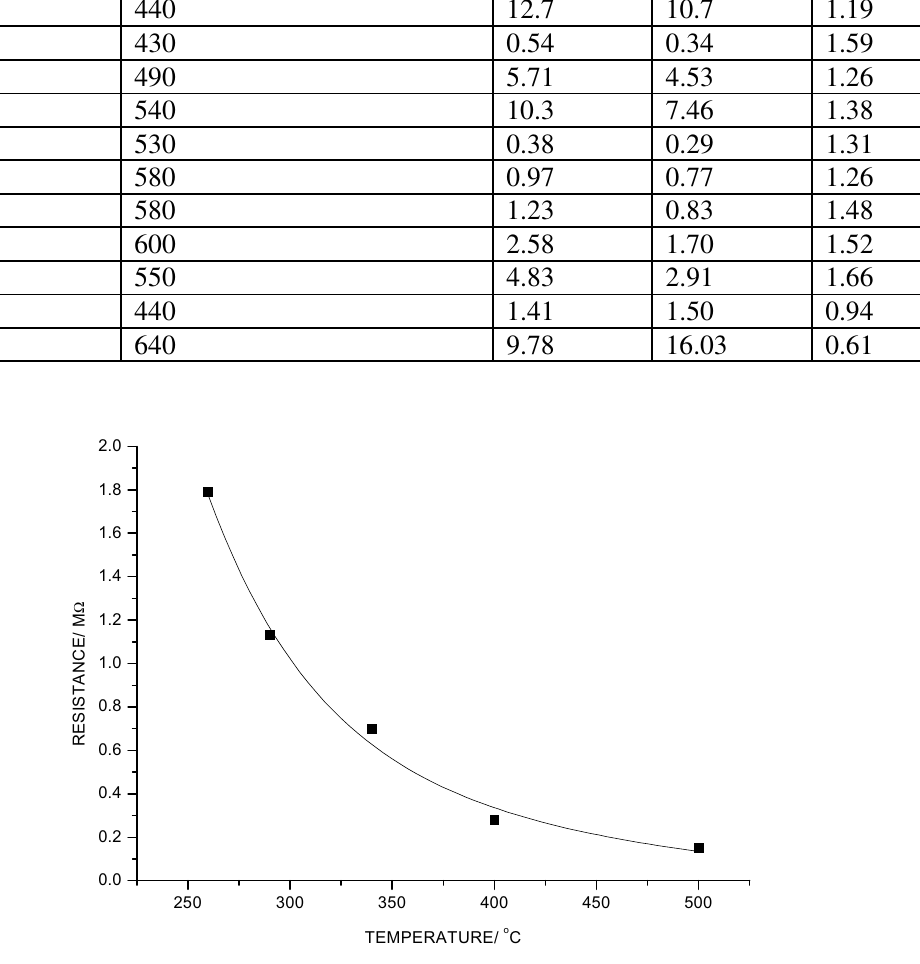
Figure 1. The resistance-temperature curve of Ag – doped CuO-BaTiO